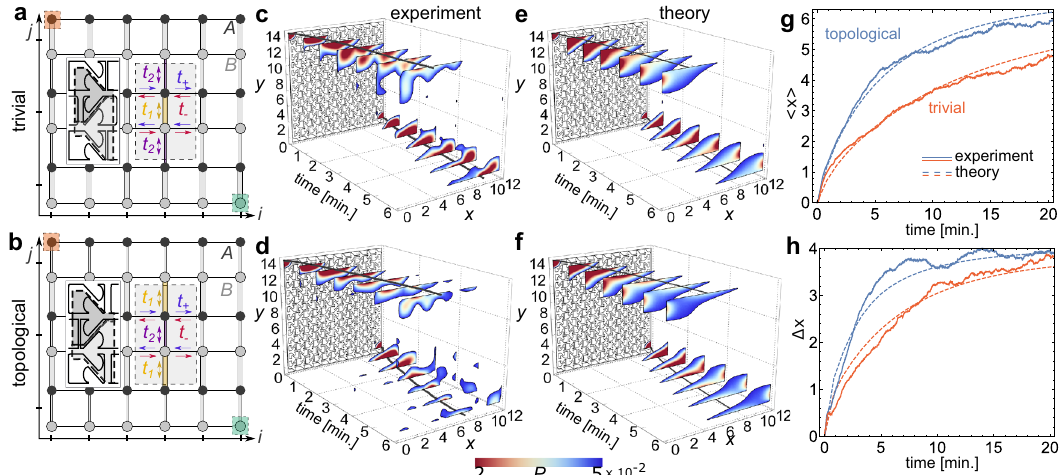
Fig. 2 Chiral edge motion. a , b Illustration of the stochastic network in Eq. (1) on which we superimpose the unit cell of the experimental device (see Fig. 1 a, b). Each dot corresponds to a cell of the device and each link represents one of the transition probabilities ( t 1 , t 2 , t + , t − ) to move in each cardinal direction (see main text). The unit cell of this lattice is the rectangle in gray, which contains black and gray nodes that are labeled by the sub-cell indexes A , B , respectively, introduced in Eq. (1). c – f Propagation of particles starting from the top left and bottom right corners (the orange and green areas in a , b ) for different times, for the ( c , e ) trivial and ( d , f ) topological device. We show both the ( c , d ) experimental and ( e , f ) theoretical behavior for ( L x , L y ) = (13, 14). The solid lines in ( c – f ) follow the average position of the particles starting from top left and bottom right corners. g Average position and ( h ) standard deviation in units of the cell index of a set of trajectories starting from either top left or bottom right corners of the device, which we compare with our model (see also Supplementary Discussion 1). The active particles of a topological device propagate faster than in a trivial device.